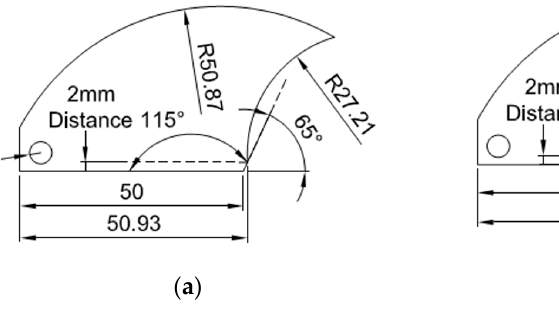
Figure 9. New templates for measuring the toe angle: ( a ) for 115°; ( b ) for 155°; ( c ) example of measurement.